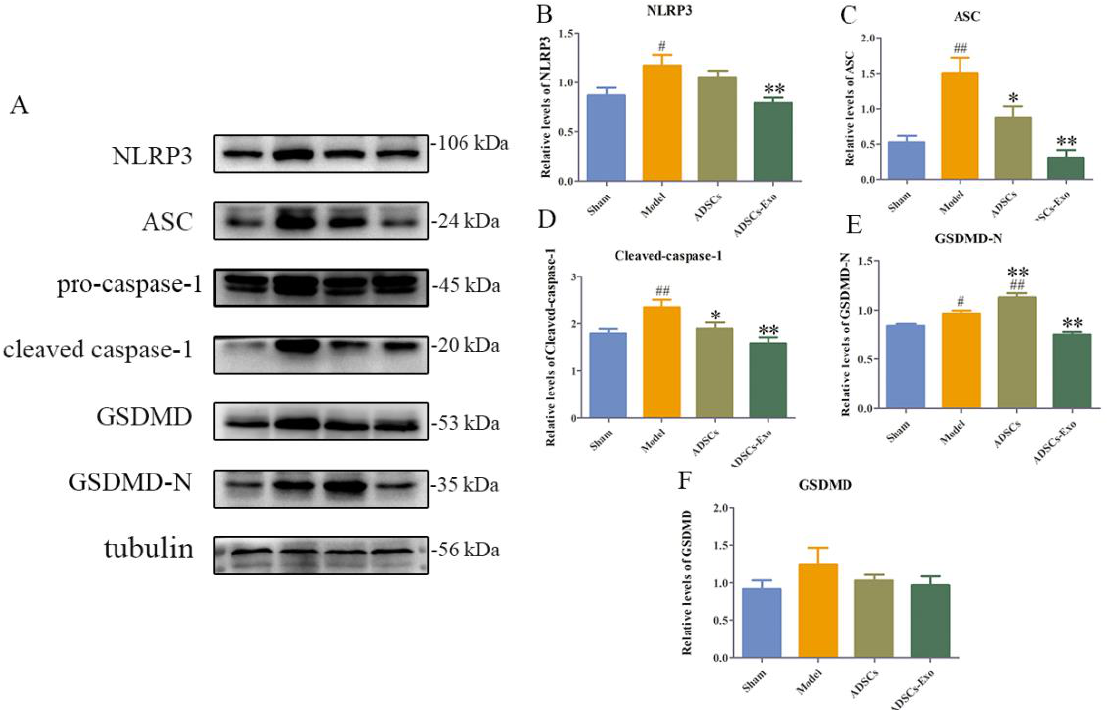
Figure 2. ADSCs-Exo decreased the protein expression of pyroptosis in the liver. Representative Western blot analysis of NLRP3, ASC, pro-caspase-1, cleaved caspase-1, GSDMD, and GSDMD-N ( A ). Quantification of NLRP3, ASC, cleaved caspase-1, GSDMD-N, and GSDMD ( B – F ). The data are expressed as mean ± SD. # p < 0.05 and ## p < 0.01, versus the Sham group. * p < 0.05 and ** p < 0.01, versus the Model group.